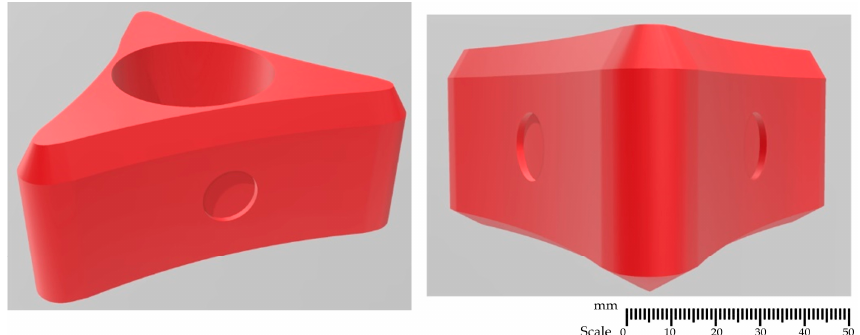
Figure 4. A 3D model—‘red triangle’ impeller with three holes—variant RT3.